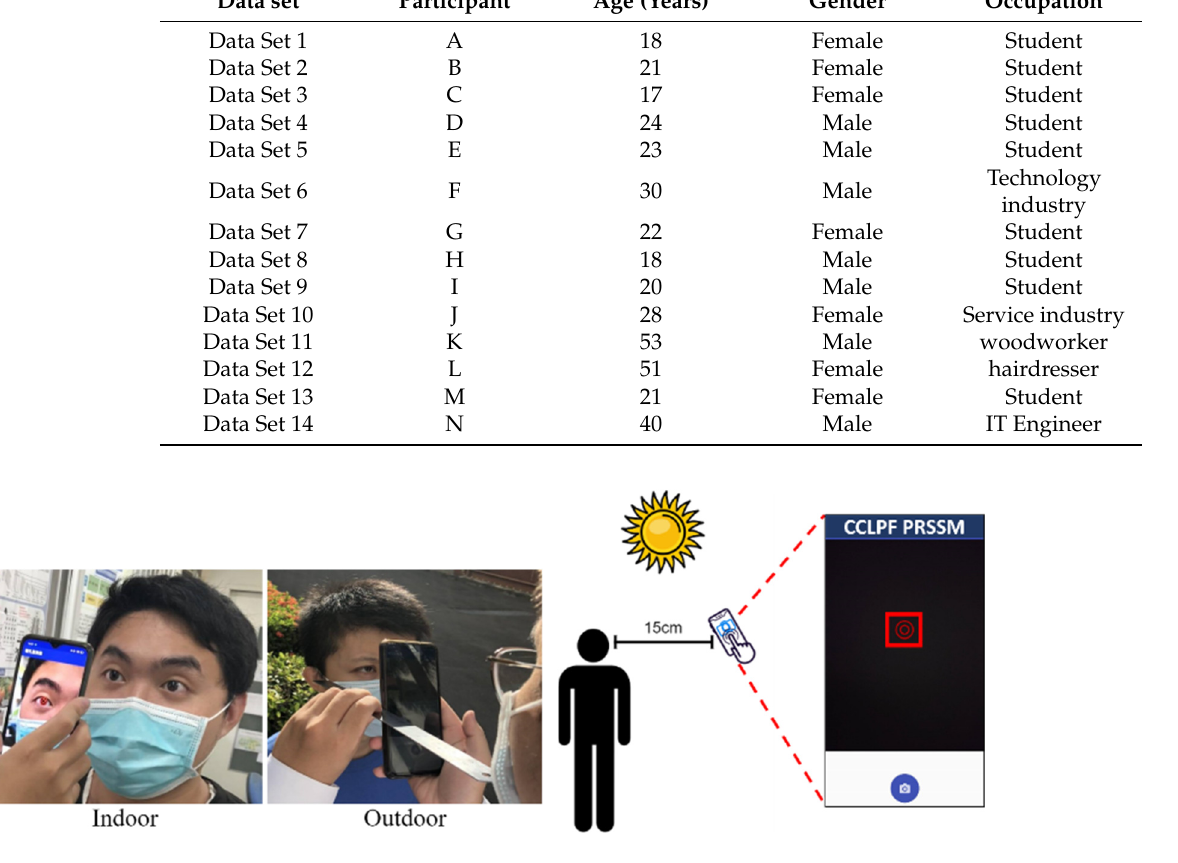
Figure 47. Schematic of the experiment data set. Table 4. Sources of each experimental data set.